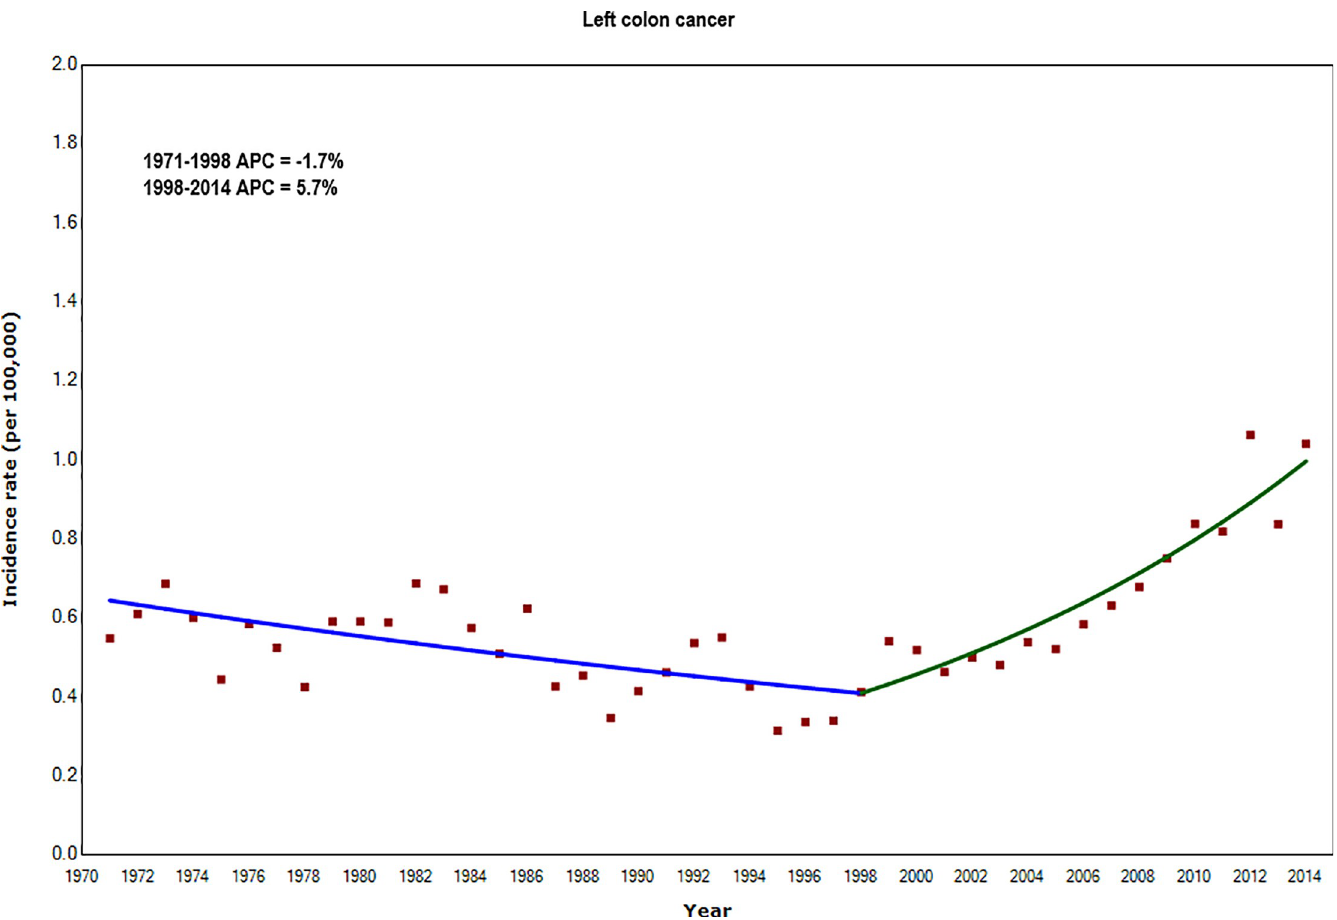
Fig 2. Annual Percentage Change (APC) in incidence rates of left colon cancer for adults aged 20–39 years: England